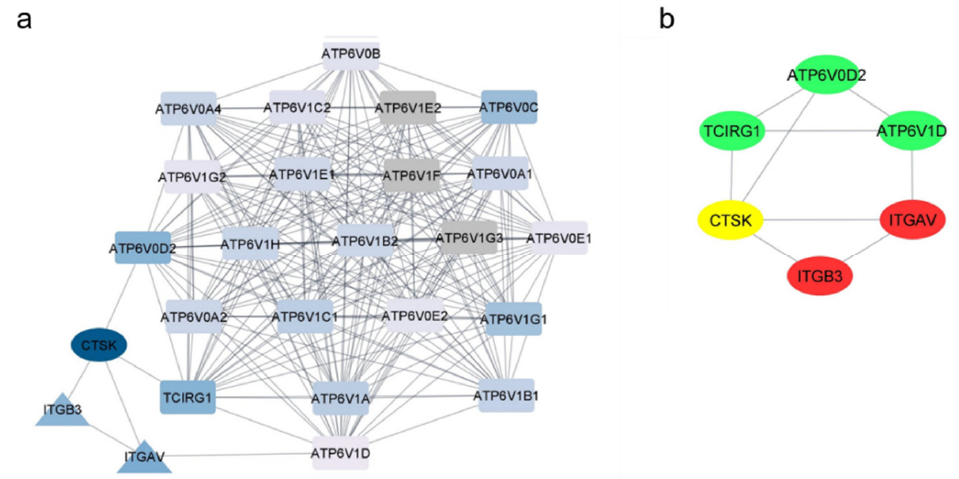
Figure 2. The input genes present in the different box styles such as ellipse for Cathepsin K, triangle for integrin receptor, and round rectangle for V-ATPase. Nodes represent protein, and edges represent interactions. ( a ) The gene expression in bone tissues are mapped to the node color; nodes with high expression are colored dark blue, while those of low expression are colored gray. The blue gradient is used to define the location of genes in bone tissue. A total of 25 enriched modes with PPI enrichment p -value of <1.0 × 10 − 16 . ( b ) The most significant genes from the PPI network (node color: yellow indicates the Cathepsin K gene, green indicates the V-ATPase genes, and red indicates the α V β 3 integrin genes).